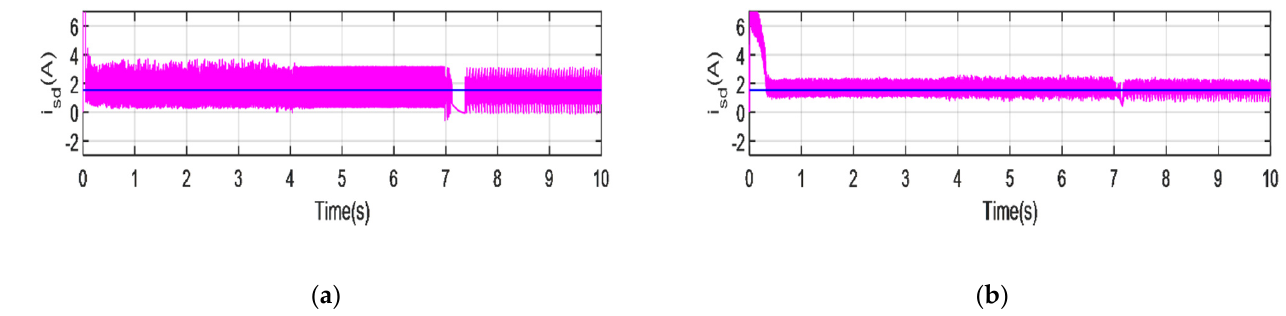
Figure 17. Isd components: ( a ) conventional inverter; ( b ) five-level inverter.